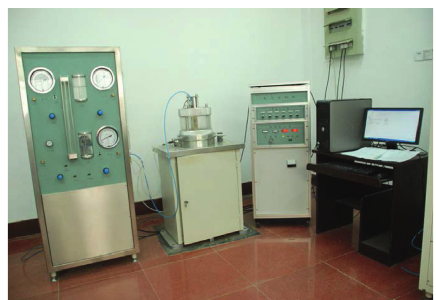
Figure 1: Grain size distribution of the clay.